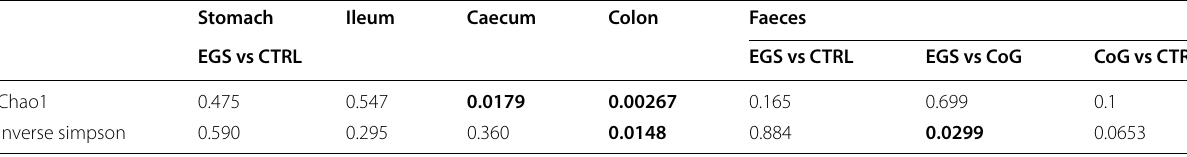
P values indicating significantly higher alpha-diversity in EGS samples are in